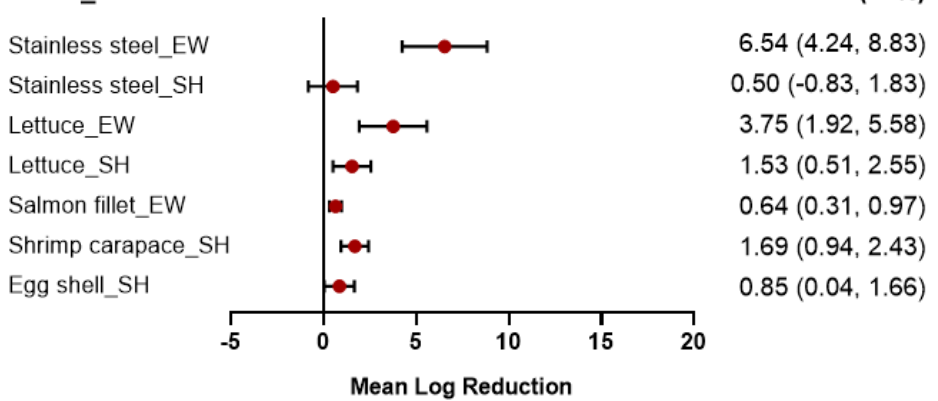
Figure 4. Forest plot of the predicted log reduction in L. monocytogenes on different matrices treated by 0.01% SH at 25 °C, 1 min, or 0.01% EW at 25 °C, 15 min.